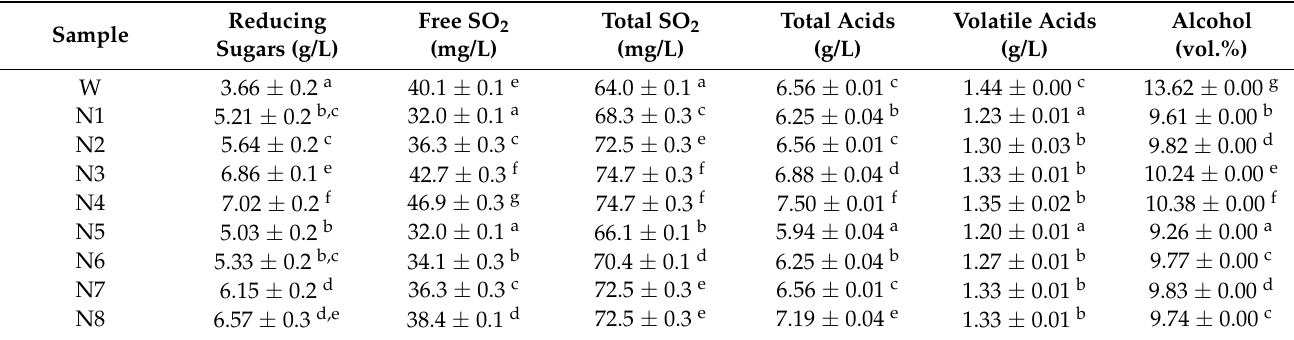
Table 2. Chemical composition of initial Cabernet Sauvignon wine variety and nanofiltration retentates at 2.5, 3.5, 4.5 and 5.5 MPa with cooling (C) and without cooling